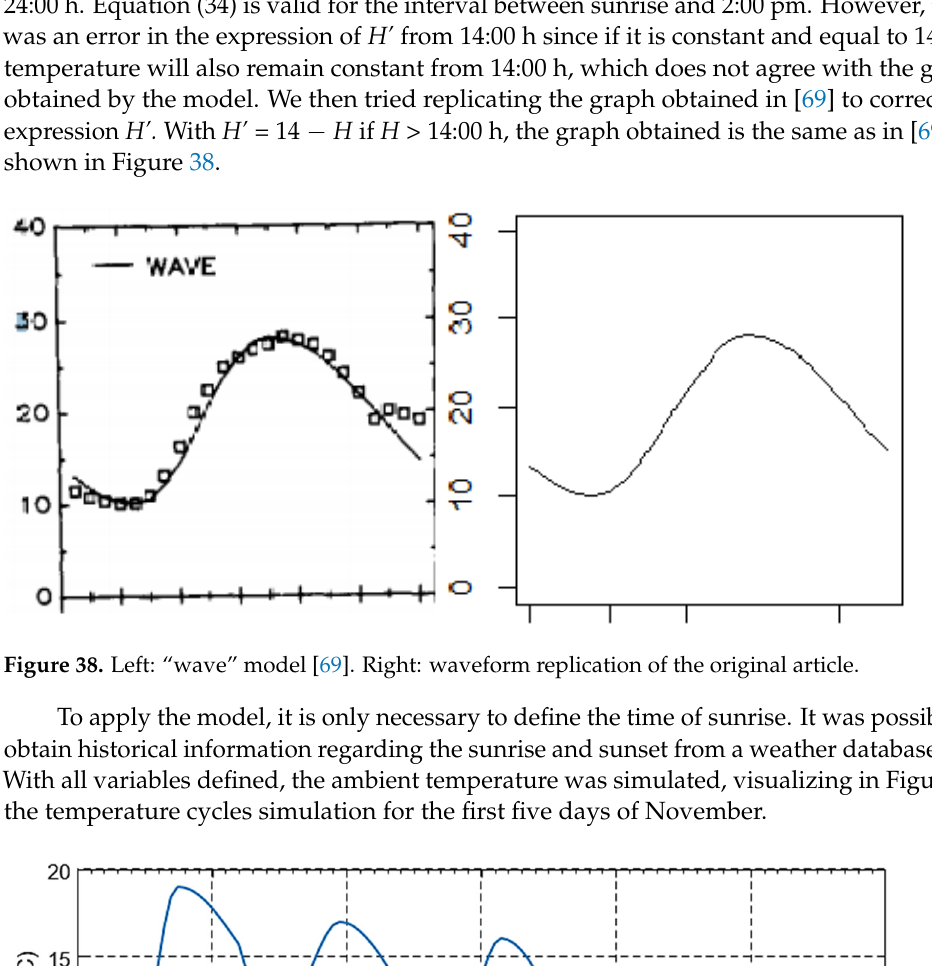
Figure 40. Simulated (blue) and measured (orange) ambient temperature for January. Figure 41. Simulated (blue) and measured (orange) ambient temperature for August.